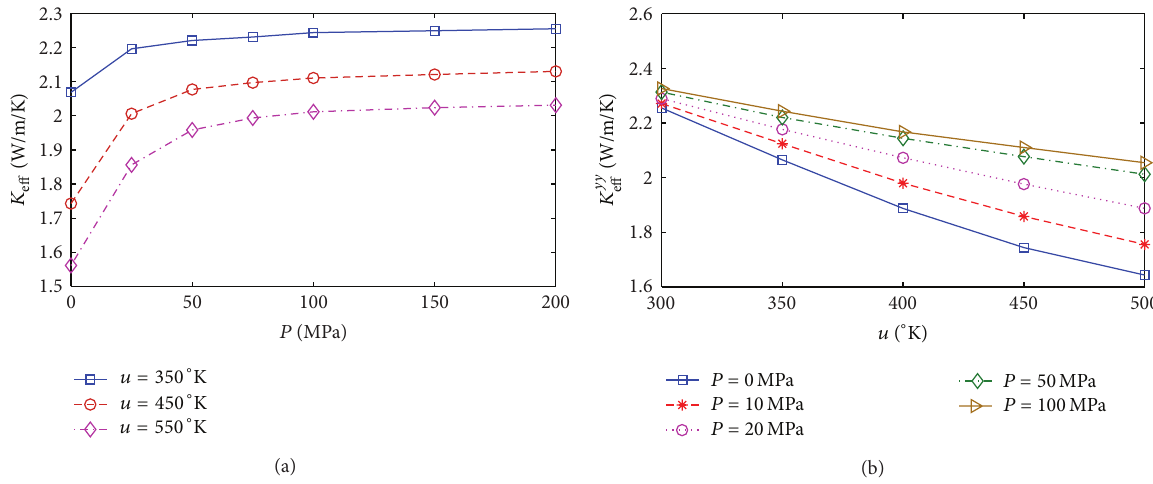
Figure 9: Effective thermal conductivity of the randomly heterogeneous media as a function of pressure and temperature.